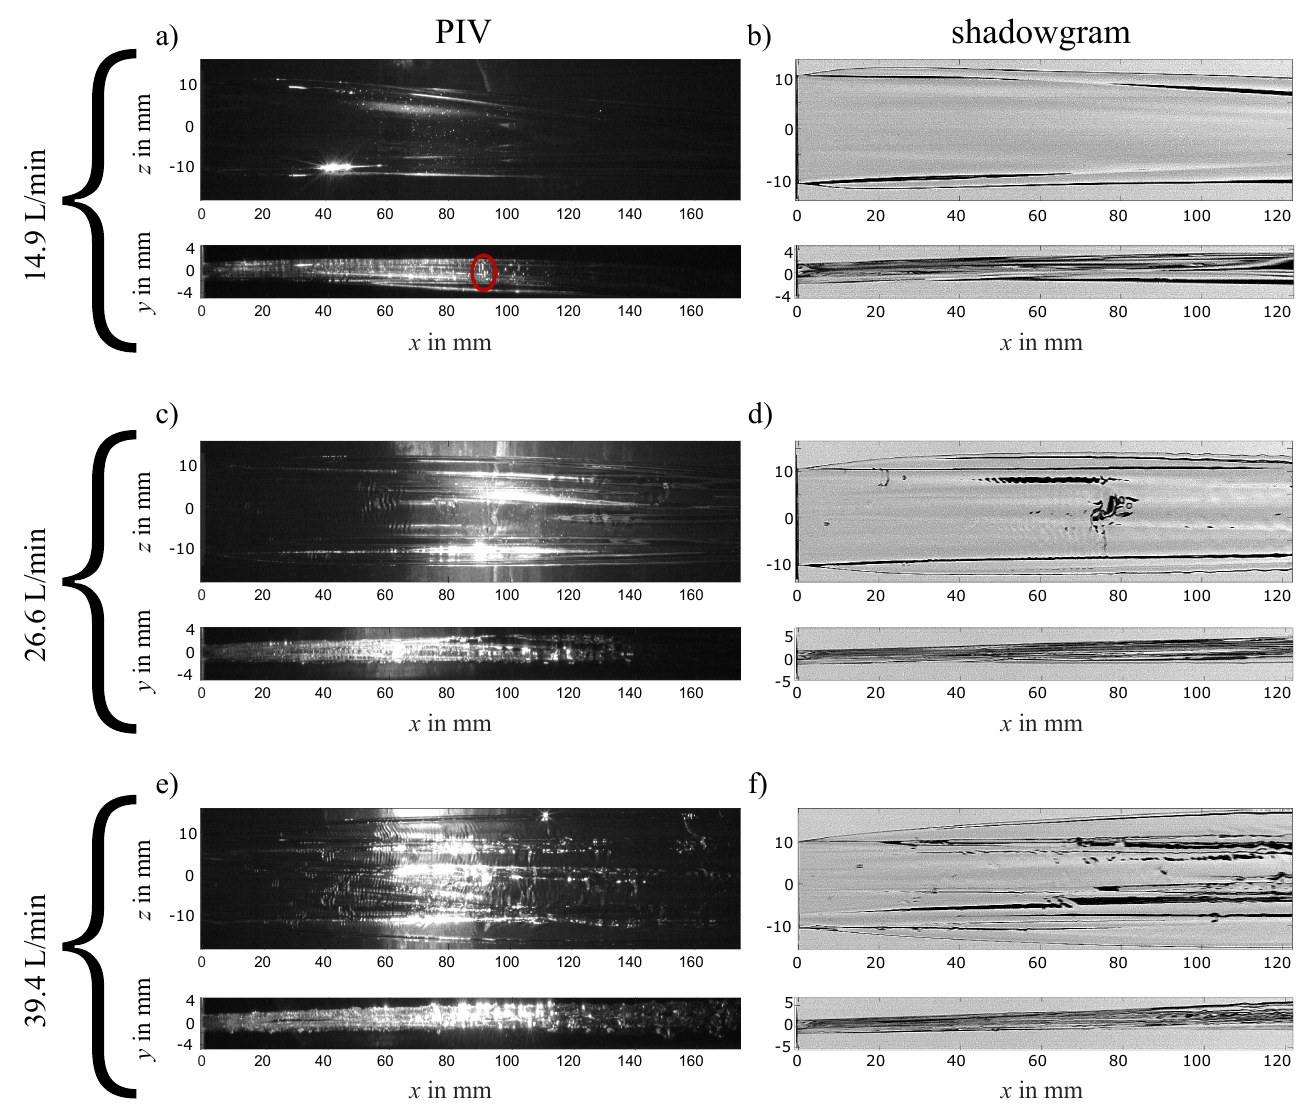
Figure 5. Images of the free jet region for the top view and the side view captured with PIV ( left ) and shadowgram imaging ( right ). The top view and the side view for each volume flow is displayed as a pair. ( a ) laminar flow visualised with PIV and red circle highlighting the impact of light refraction; ( b ) laminar flow visualised shadowgram; ( c ) laminar–transient flow visualised with PIV; ( d ) laminar–transient flow visualised shadowgram; ( e ) turbulent flow visualised with PIV; ( f ) turbulent flow visualised